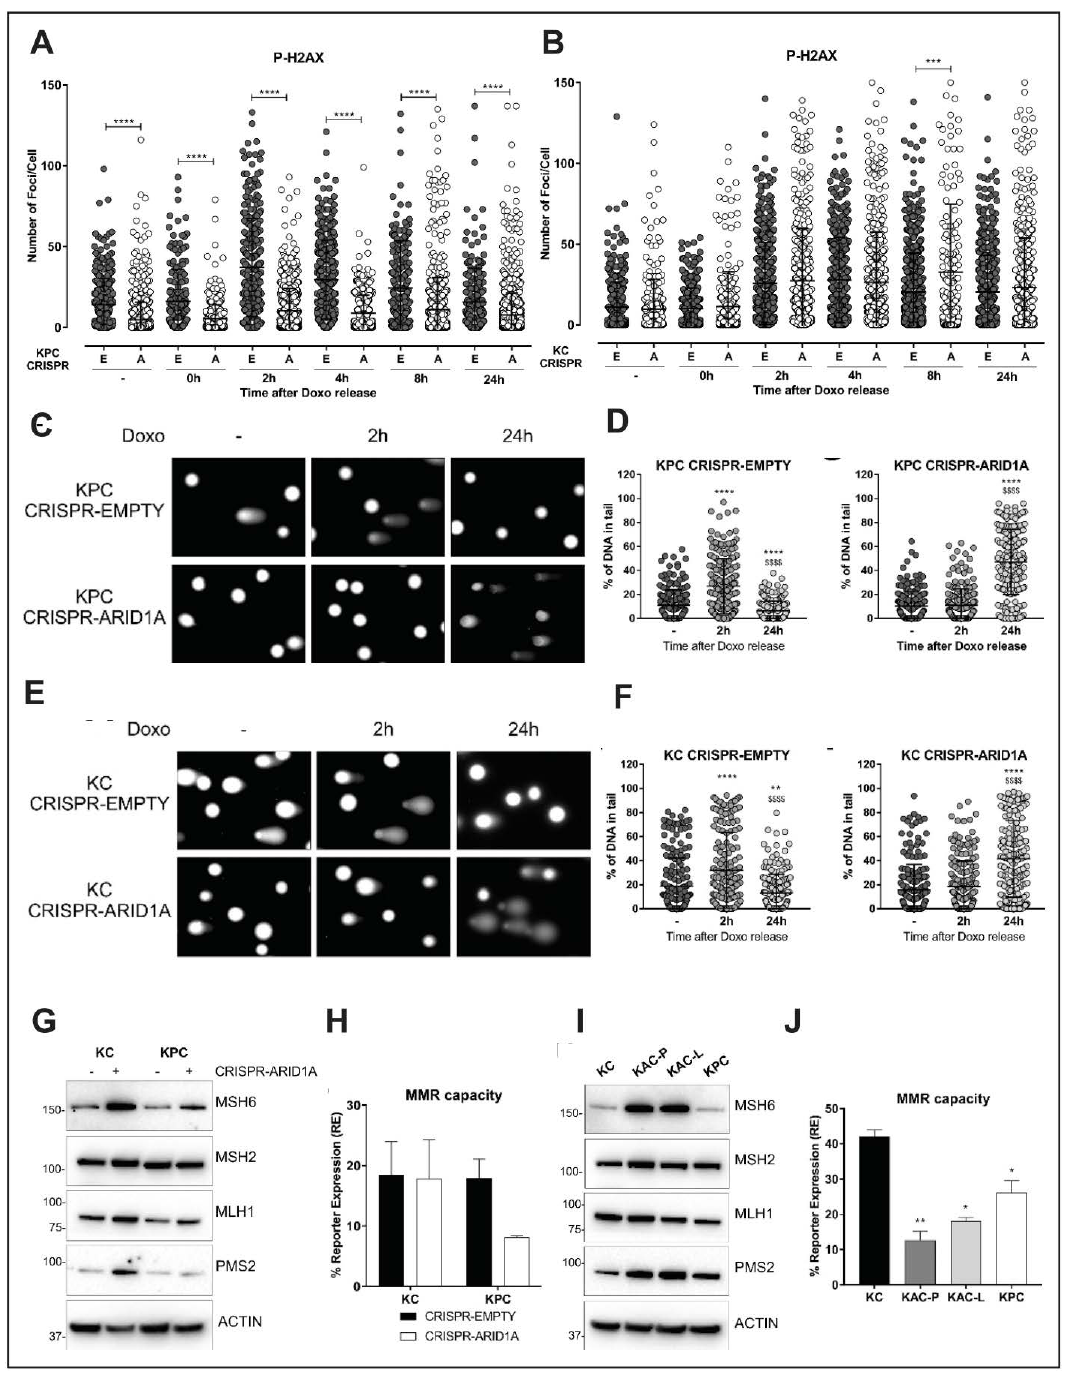
Figure 6. Loss of Arid1a impairs DNA damage and mismatch repair. ( A , B ) Quantification of immunofluorescent staining for phospho-gH2AX in isogenic pair of “KPC” ( A ) or “KC” ( B ) cell lines transfected with either empty vector ( E ) or Arid1a-targeting CRISPR ( A ), and exposed to DNA damaging agent like 0.1 µ M Doxorubicin (Doxo) for 30 min, then released for the indicated time points. Graph representative of 3 independent experiments, show the quantification of number of foci / cell performed with iMaris Microscopy Image Analysis Software (Bitplane) and showing lower number of p-gH2AX positive foci only in Arid1a -deleted “KPC” cells but not “KC” cohort. ( C – F ) Comet assay using Doxo treated isogenic pairs of “KPC “( C , D ) and “KC” ( E , F ) cells lines showed impaired DNA damage repair in Arid1a -deleted cohort of both pairs. Representative images (left panels) and scatter plots with quantification of the comet tail intensity relative to the head, expressed in % of DNA in